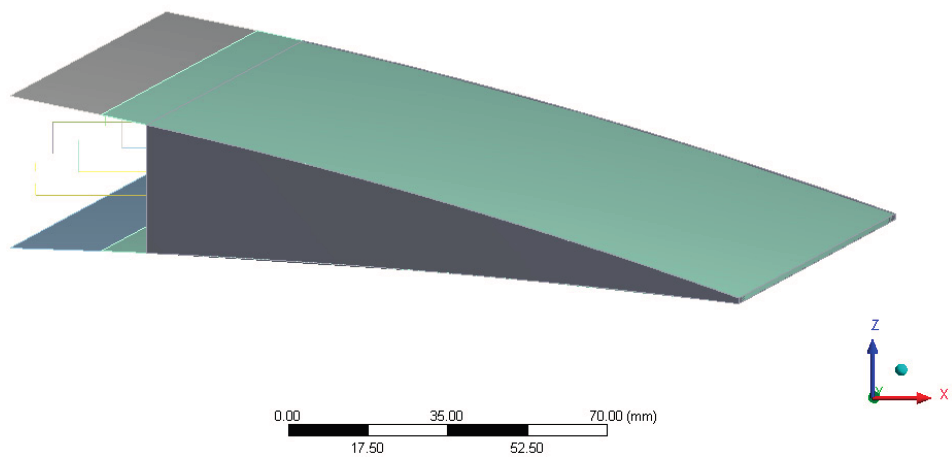
Figure 11. The geometric model of closed cell design for finite element model.